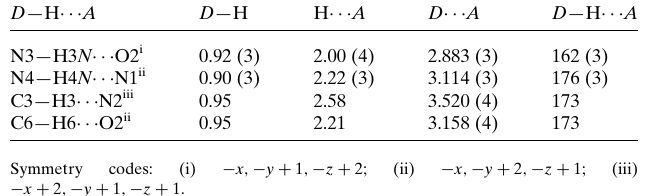
Table 1 Hydrogen-bond geometry (A˚ , (cid:3) ).